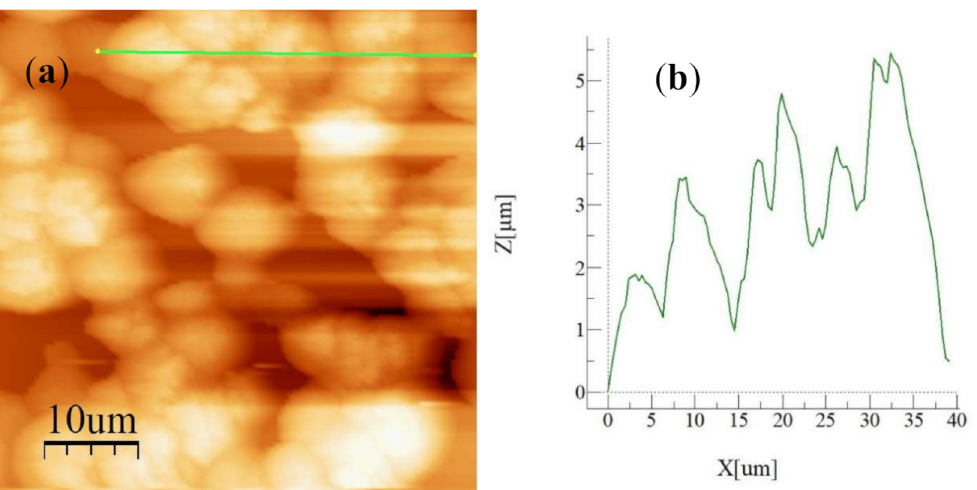
Figure 2. AFM (Atomic Force Microscope) surface image and line scan: ( a ) micro-image of the surface. The small bright spots represent the spherules and brightness is related to the height of the spherules (brighter the spot corresponds to higher the spherules), and ( b ) line scan, which is taken over the crystallized surface. It is shown as a green line in Figure 2a. It provides information on the height of the